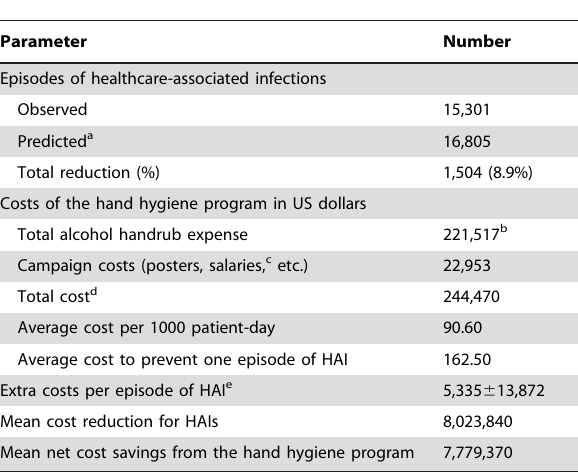
Table 2. Decrease in Healthcare-associated Infections and Cost Savings Attributed to the Hand Hygiene Program.